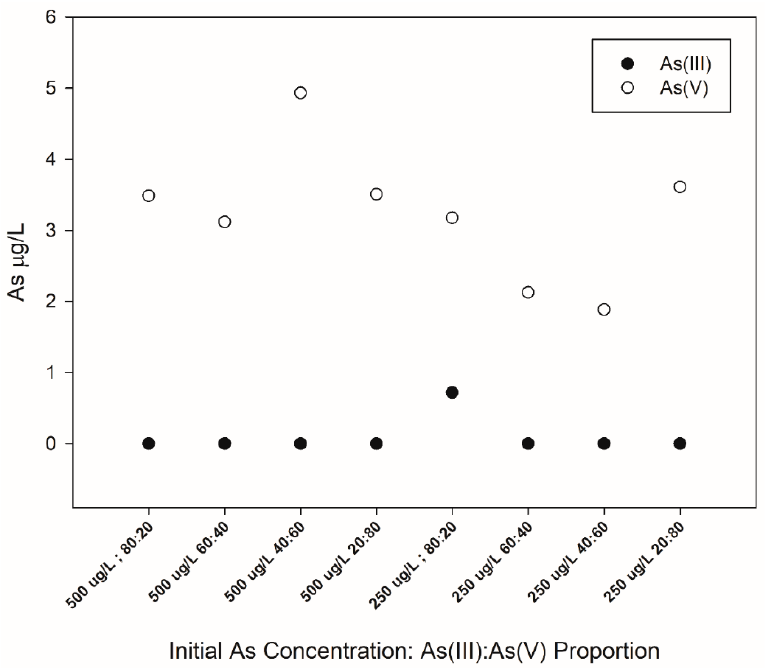
Figure 5. Final arsenic concentration per species at different final As(III):As(V) concentrations and proportions.